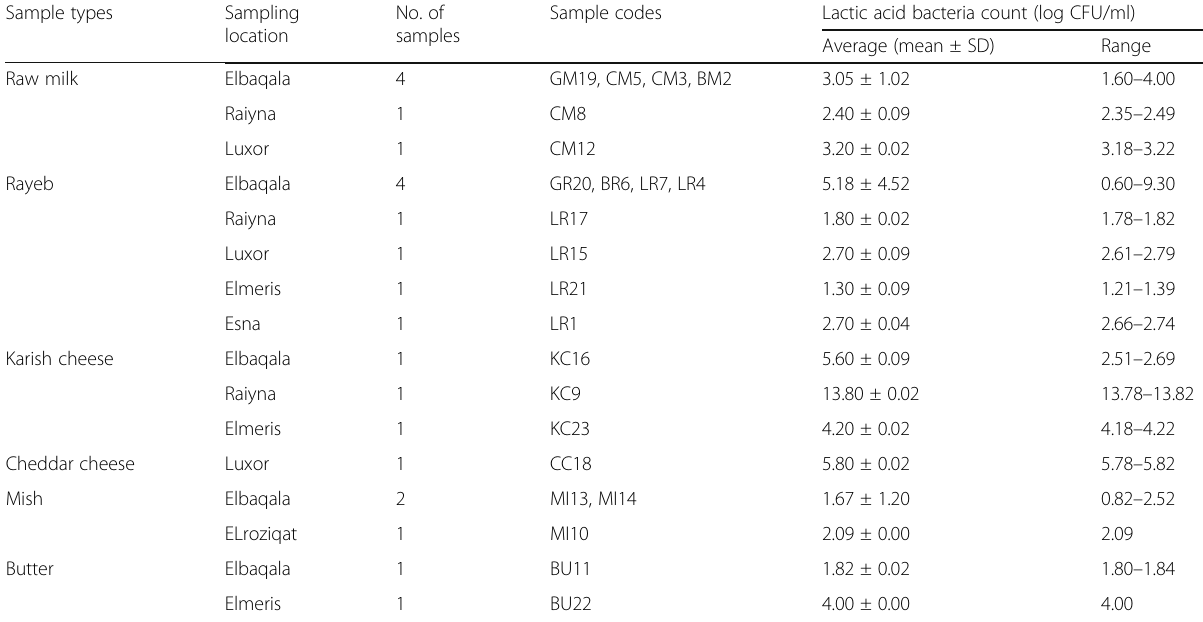
Table 2 Samples, sampling locations, and lactic acid bacteria (LAB) count (log cfu/ml or g) of milk and dairy products Sample